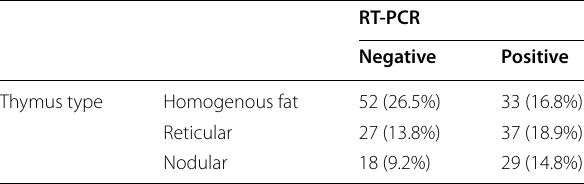
Table 2 Distribution of thymus type according to RT-PCR test